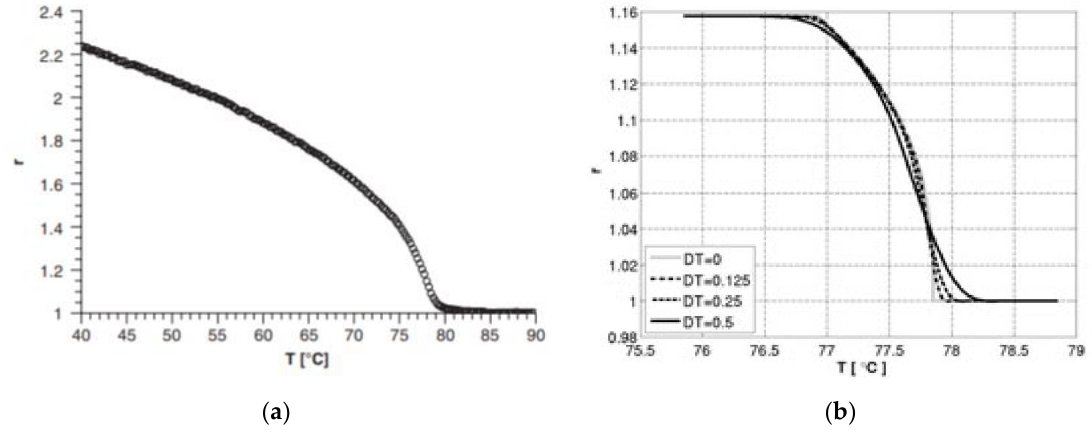
Figure 2. ( a ) [40], shows the correlation between r = and T °C, and how it depends on the nematic order parameter. Note that L denotes the length of a sample when it is in the nematic phase and LISO denotes the sample’s reference length, when it is 12 °C above threshold temperature of 78 °C. ( b ) shows the good agreement between numerical results and experimental data close to the transition temperature [39]. DT accounts for the random fluctuations added to the threshold temperature, which fluctuates specially (Reprinted with permission from [39,40]).